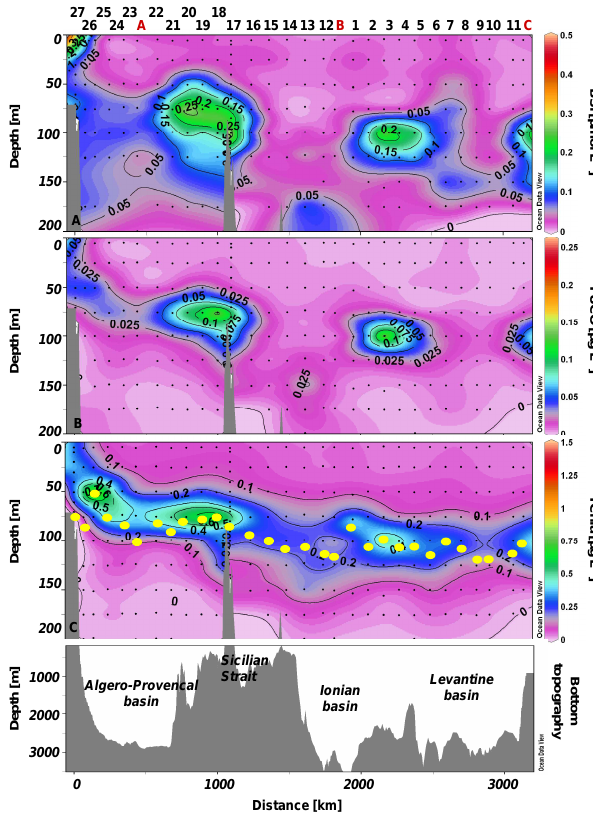
Fig. 9. (A) Distribution of biogenic silica (BSi) (µmolL − 1 ) , (B) Fucoxanthin (Fuco) (µgL − 1 ) , and (C) Total chlorophyll- a (TChl- a ) (µgL − 1 ) and depth (m) of the euphotic zone (yellow dots) during the BOUM cruise (summer